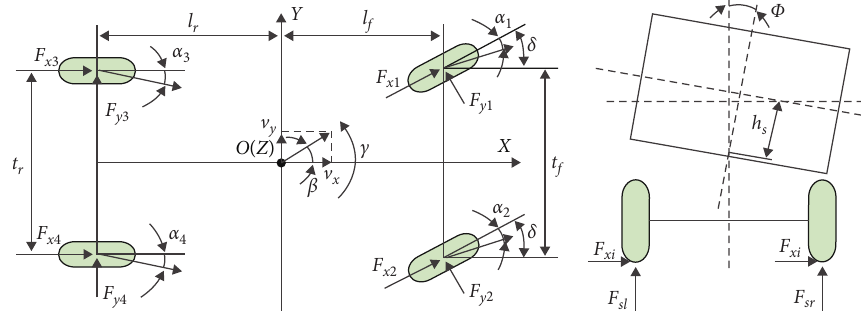
Figure 1: A 4-wheel 8-DOF vehicle mechanical model schematic